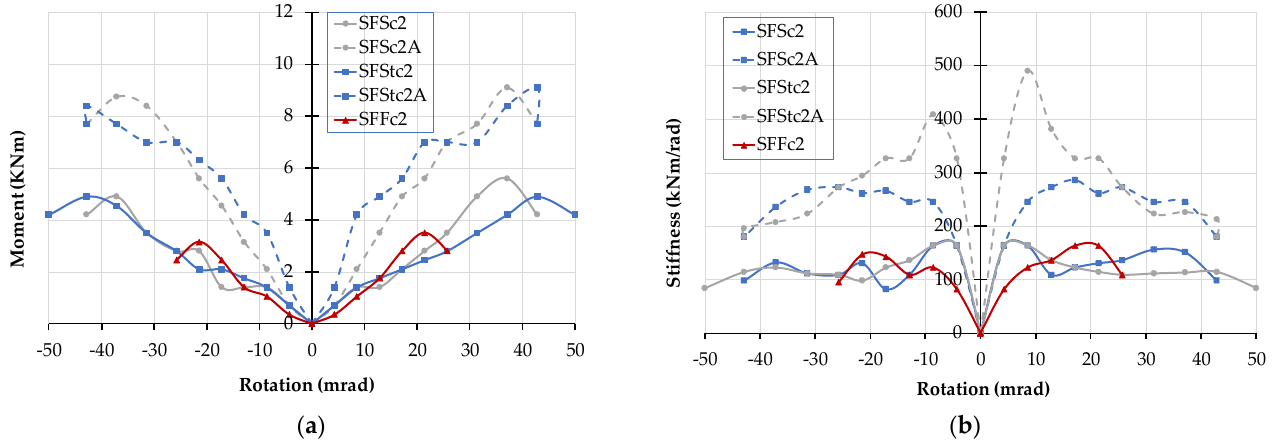
Figure 9. Moment and stiffness evolution for each joint: ( a ) Moment evolution for each test versus rotation; ( b ) Stiffness evolution for each test versus rotation.